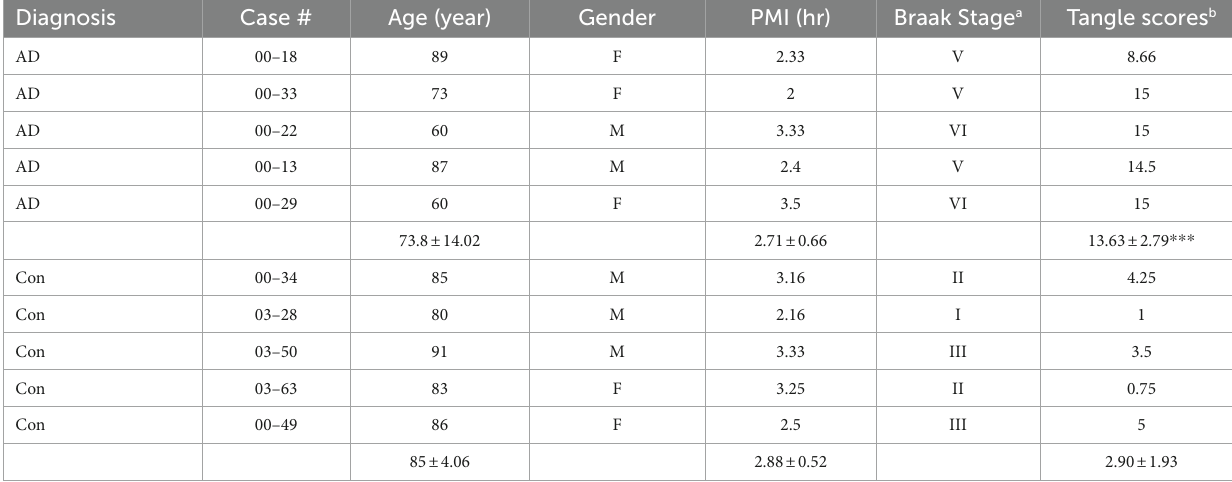
TABLE 1 Human brain tissues of Alzheimer’s disease and control cases used in this study * .